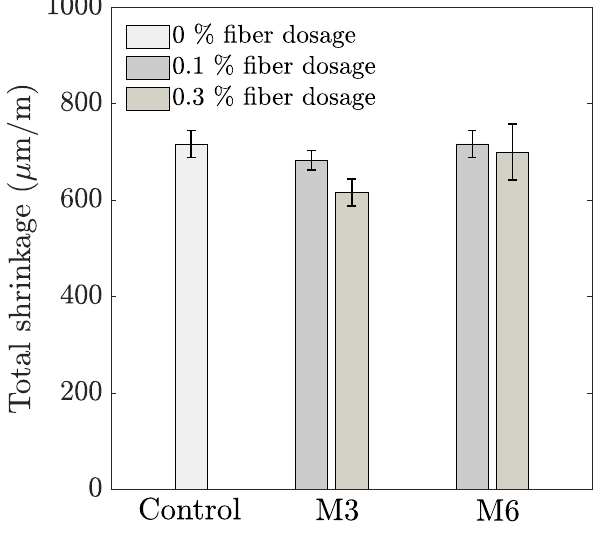
Figure 8. 28-day cumulative total free shrinkage ( n = 3).